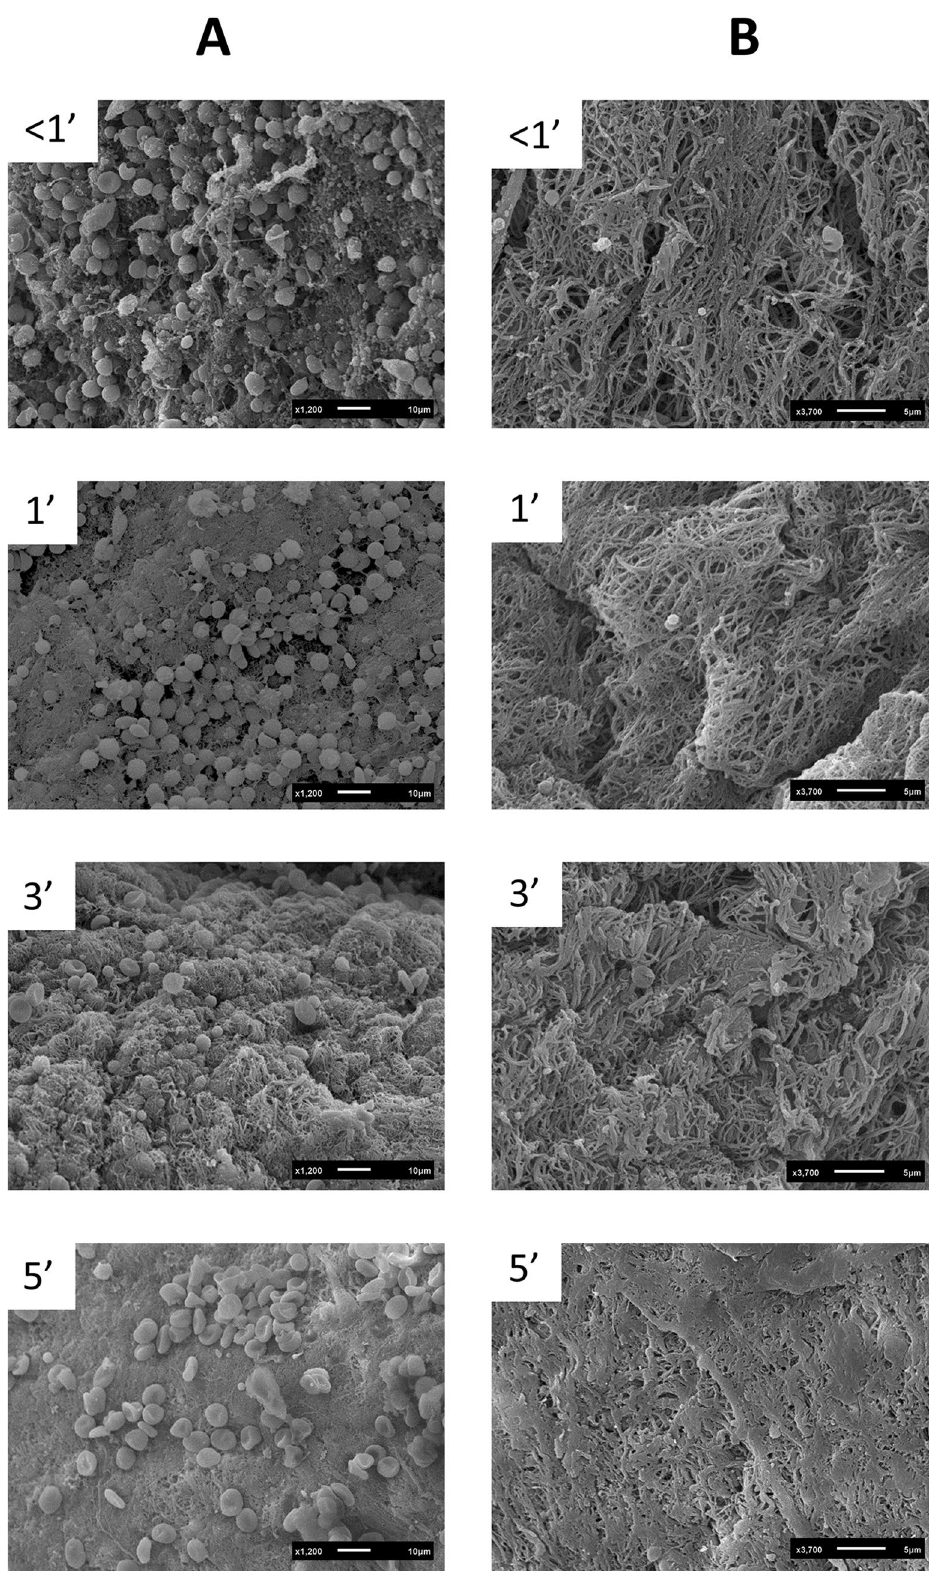
Figure 6. Scanning electron microscopy images of the L-PRF membranes with different time points (< 1 min, 1 min, 3 min, and 5 min) before centrifugation. ( A ) Represents the red part (face) of the membrane; ( B ) represents the yellow part